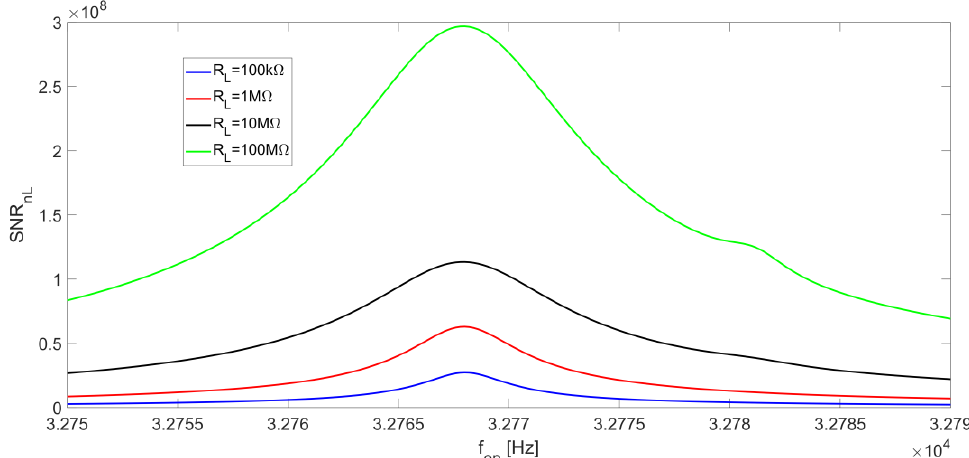
Figure 15. R L noise contribution to the SNR n at the LIA output as a function of the operating frequency, for different values of R L and at a low-pass filter bandwidth of BW = 0.5 Hz. Higher values of SNR nL are obtained for increasing values of R L values. Therefore, as reported in Equation (13), SNR np becomes dominant in the calculation of the overall SNR for large values of R L .